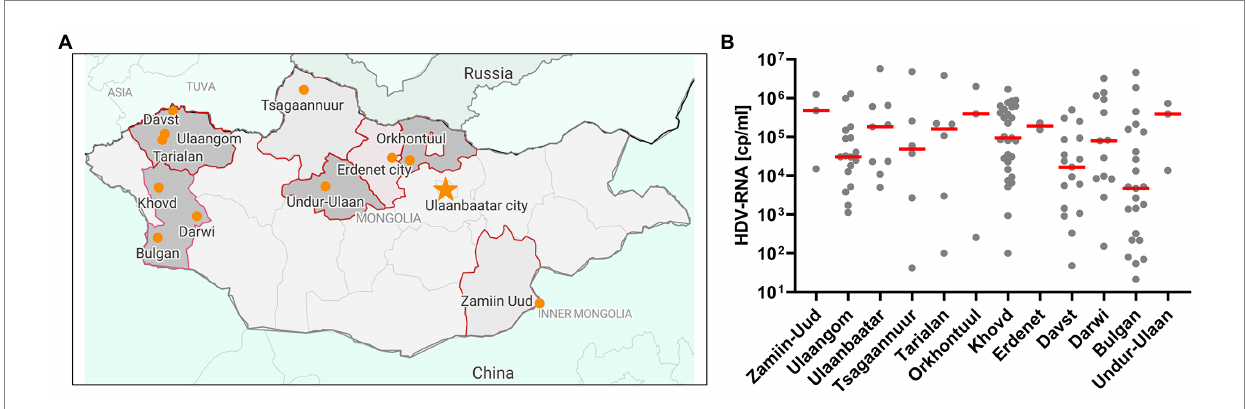
FIGURE 1 Recruitment of the HepMongolia cohort. (A) Sampling regions for the HepMongolia cohort. The map was created with data from open street map and visualized with datawrapper. (B) HDV viral load in the different sampling